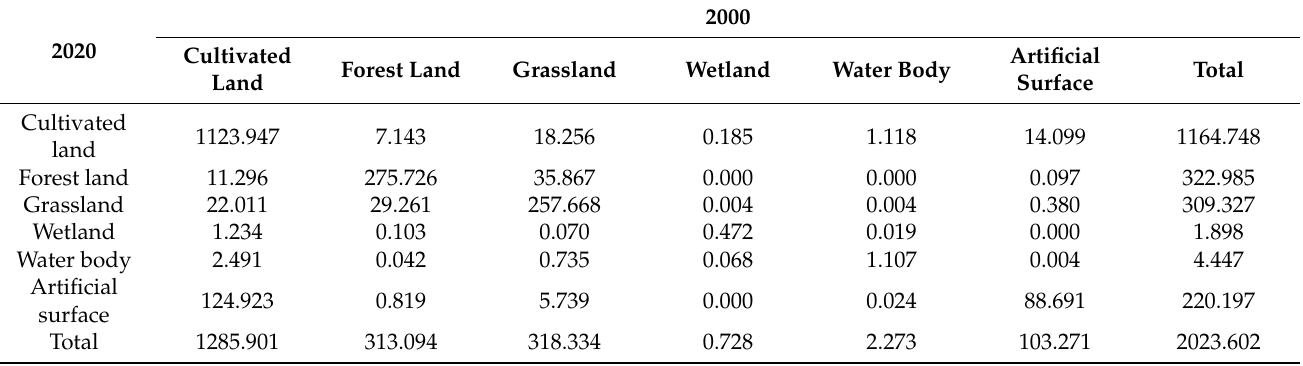
Figure 7. LUCC in mining areas of Changzhi City between 2000–2020.